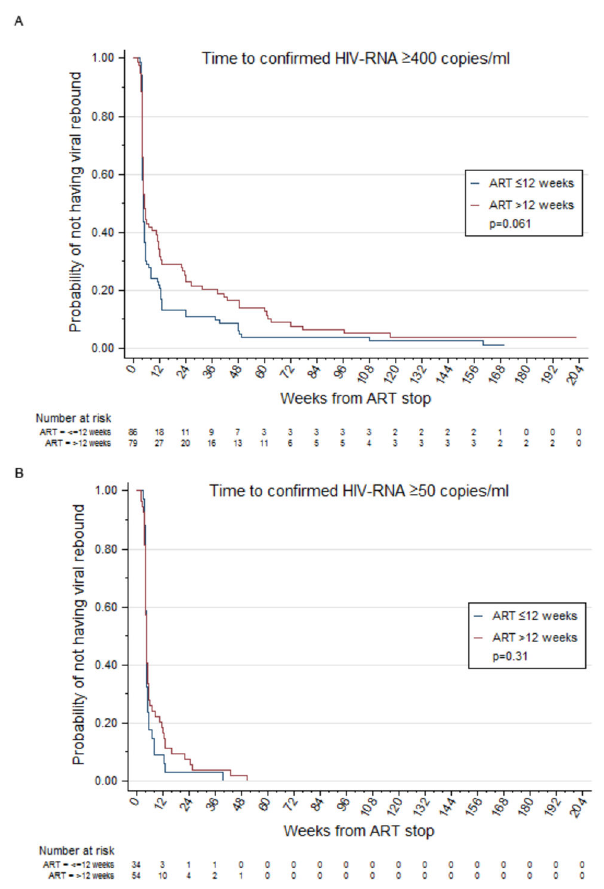
Figure 1. Time to confirmed plasma HIV-1 RNA detection by duration of ART. Kaplan Meier survival analysis showing time to virological rebound defined as (a.) <400 HIV-1 RNA copies/ml of plasma and, (b.) <50 RNA copies/ml of plasma. The x-axis shows weeks since cessation of ART. The y-axis shows proportions of participants remaining undetectable. Numbers at risk and contributing to the analysis at each time- point are shown below the x-axis. ART: antiretroviral therapy; VL = viral